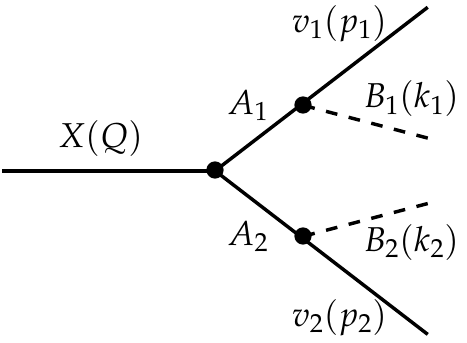
Figure 1 . The antler decay topology. A heavy resonance ( X ) decays to a pair of lighter intermediate particles ( A 1 ; 2 ), and they subsequently decays into a pair of visible ( v 1 ; 2 ) and invisible particles ( B 1 ; 2